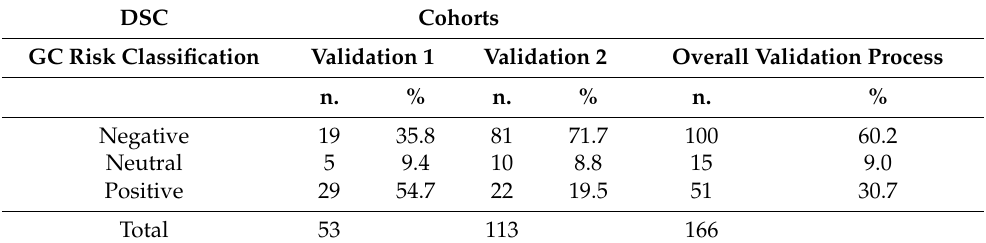
Table 2. DSC GC risk classifications for participants in the validation cohorts.